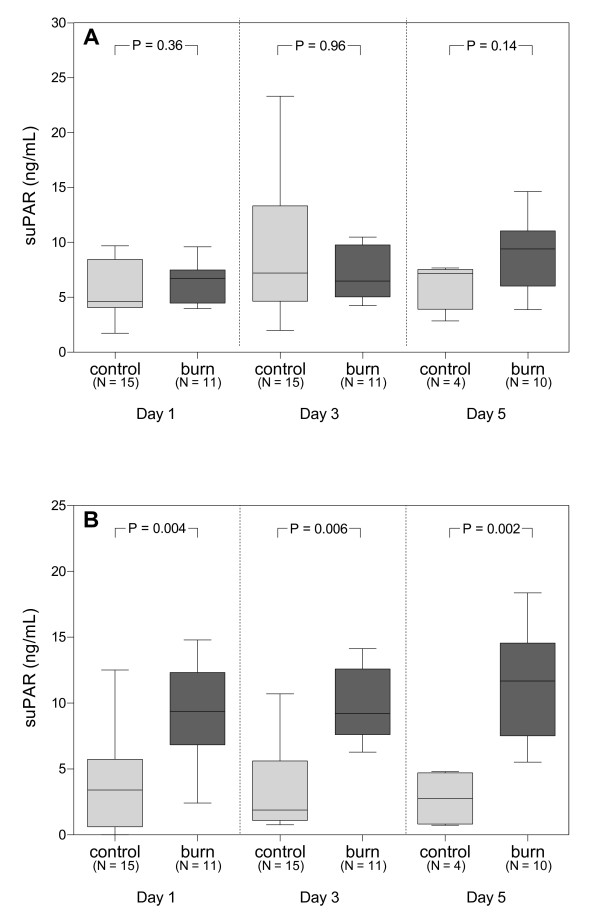
Systemic and pulmonary levels of soluble urokinase-type plasminogen activator receptor (suPAR). (a) Box plots of systemic levels of suPAR; systemic levels of suPAR do not significantly differ from levels in control patients on admission and on days 3 and 5 after admission. (b) Box plots of pulmonary levels of suPAR; compared with those in control patients, pulmonary levels of suPAR are significantly higher in burn-injury patients on admission and on days 3 and 5 after admission. Boxes represent the interquartile ranges. Outliers are excluded from the figure. N, number of patients per group per time point. The P values indicate statistical significance.